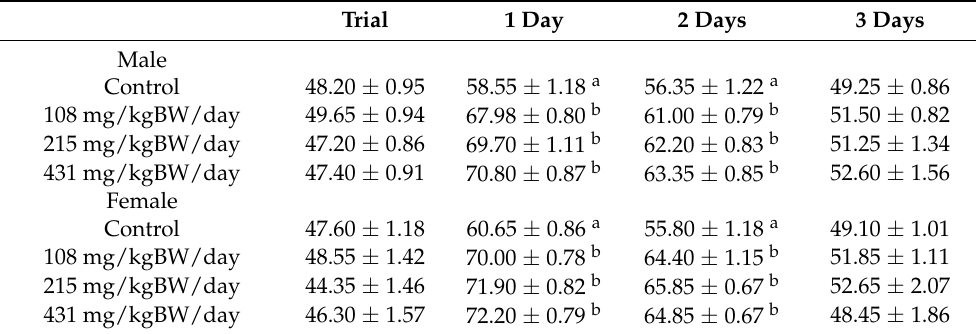
Table 1. Single-trial passive avoidance latency time in mice after 12 weeks feeding.